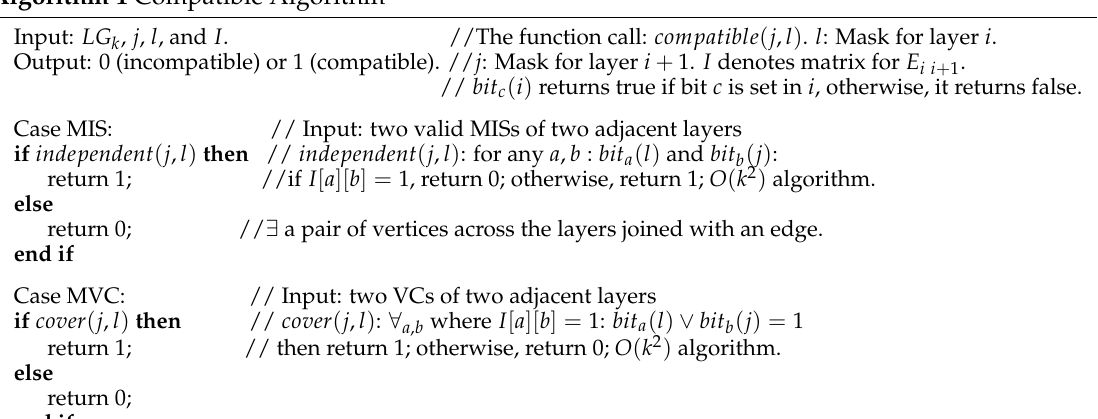
Algorithm 1 Compatible